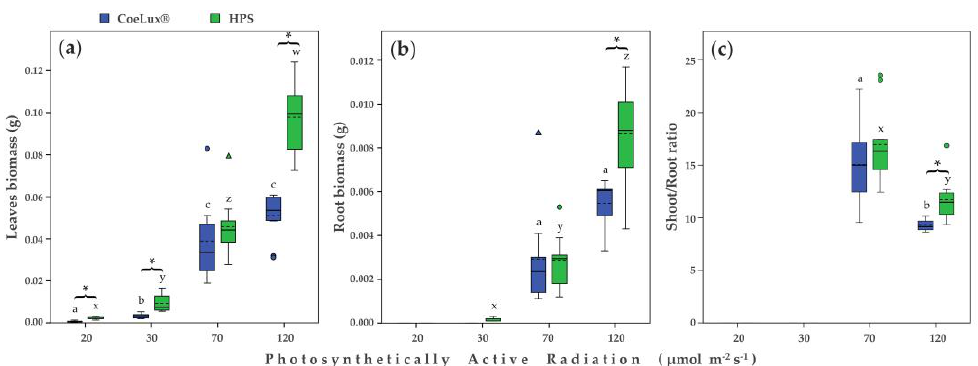
same light intensity. Letters indicate statistically significant differences ( p < 0.05) between plants grown under different light intensities within the same light type. Vertical boxes represent approximately 50% of the observations, and lines extending from each box are the upper and lower 25% of the distribution. Within each box, the solid horizontal line is the median value, whereas the dotted horizontal line is the mean.